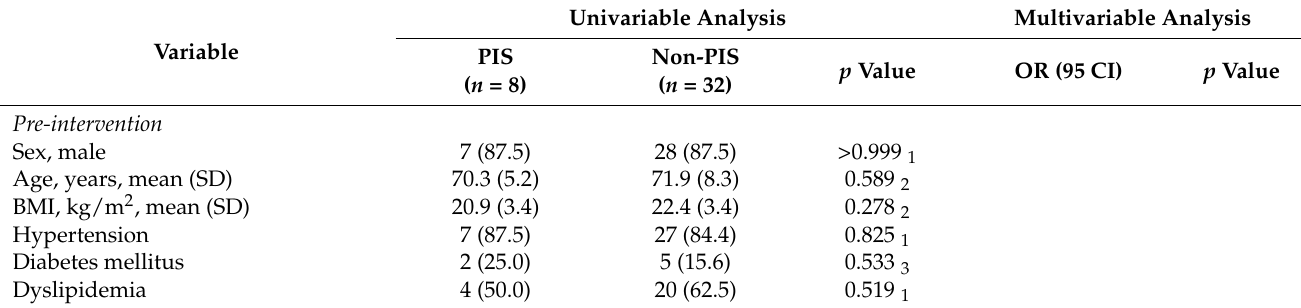
Table 2. Pre-, intra-, and post intervention risks of EVAR-related peri-intervention strokes by univari- able analysis and multivariable